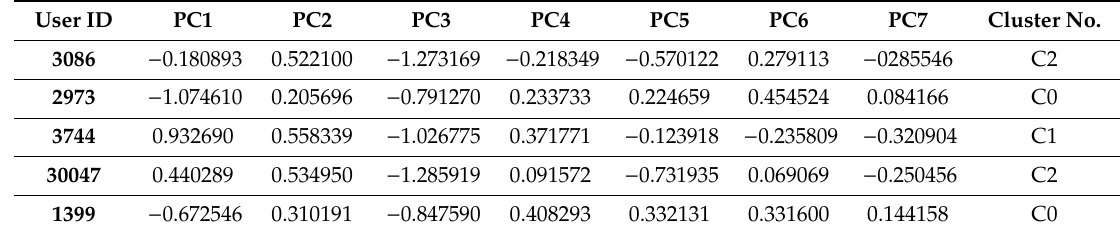
Table 3. Individual positioning of users within K-means clusters. ID—identifier.